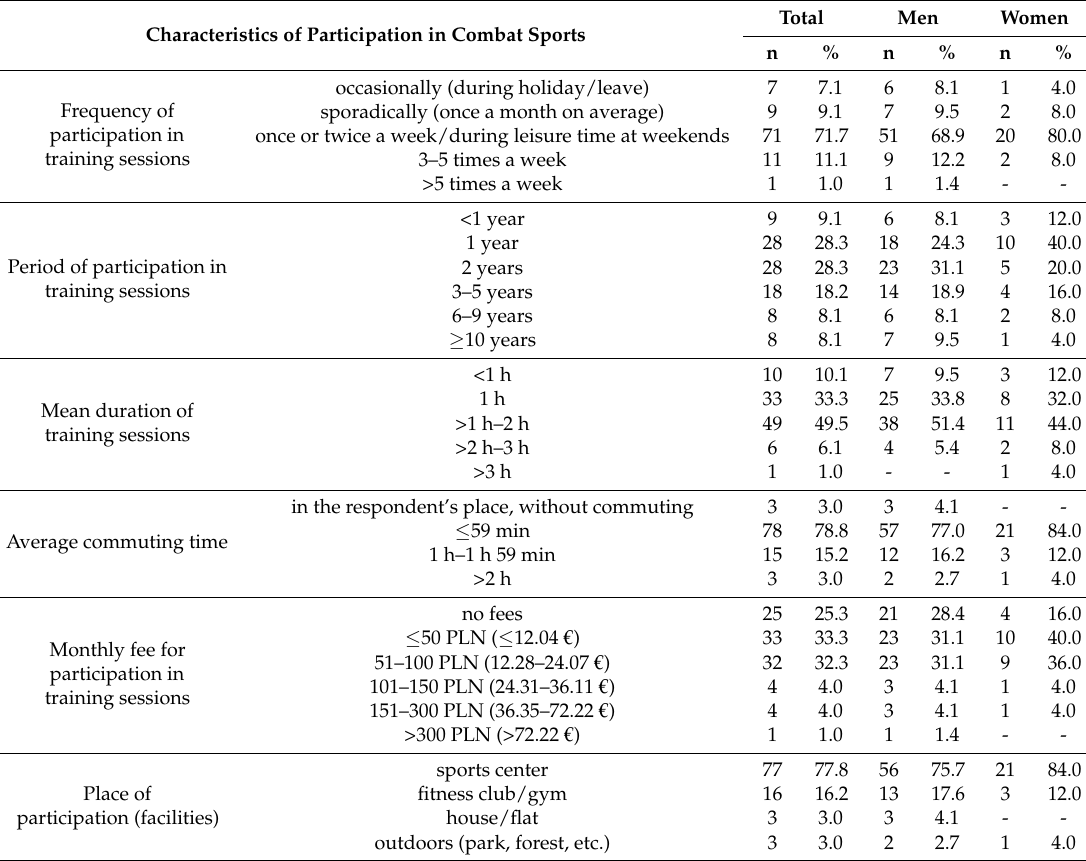
Table 4. Particular characteristics of participation in combat sports according to